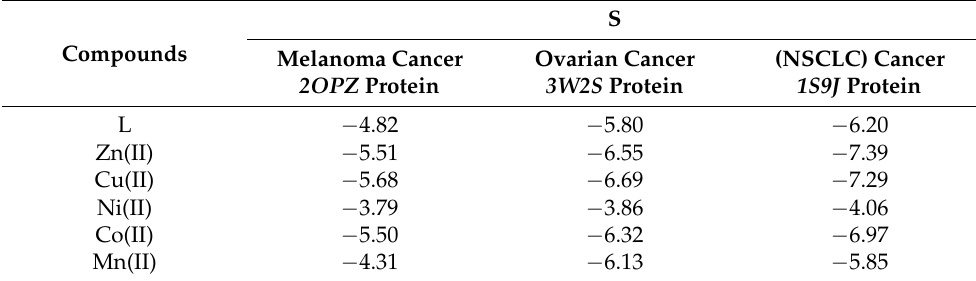
Table 4. Docking energies for three types of protein with the